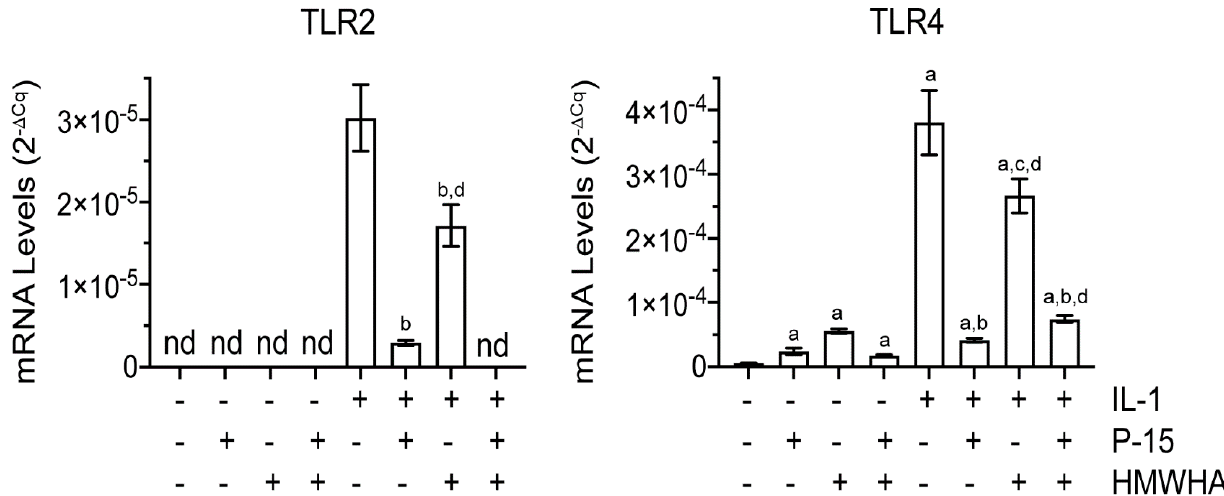
Figure 2. mRNA levels of Toll—like receptor 2 (TLR2) and Toll—like receptor 4 (TLR4) in vehicle—treated or IL—1 β — treated human BMSCs cultured in the absence or presence of P15—1 and HMWHA. Human BMSCs were serum—starved for 24 h followed by treatment with vehicle or IL—1 β in the absence or presence of P15—1, HMWHA, or P15—1 and HMWHA for 48 h. The mRNA levels of TLR2 and TLR4 were determined by real—time PCR using SYBR Green and normalized to the level of 18S RNA. Data were obtained from triplicate PCRs using RNA from 3 different cultures. Values are the mean ± SD. a p < 0.01 vs. vehicle–treated cells; b p < 0.01 vs. IL–1 β -treated cells; c p < 0.05 vs. IL–1 β -treated cells; d p < 0.01 vs. IL-1 β /P15–1–treated cells; nd, not detected.